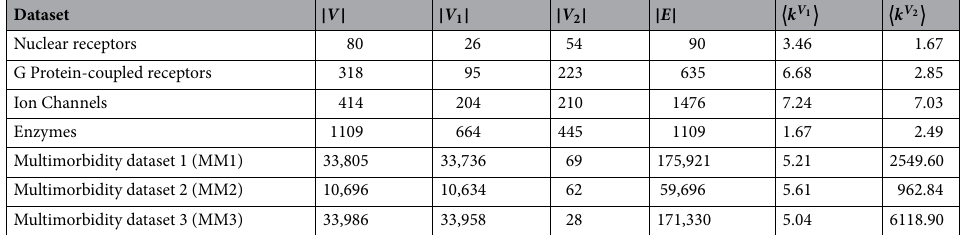
Table 1. Topological properties of the networks used. Here, | V | and | E | are the number of nodes and links respectively, | V 1 | and | V 2 | are the number of nodes in the left and the right side of the bipartite graph V 1 k V 2 respectively, and (cid:31) k (cid:30) and (cid:31) (cid:30) are the average degrees of the nodes in the sets